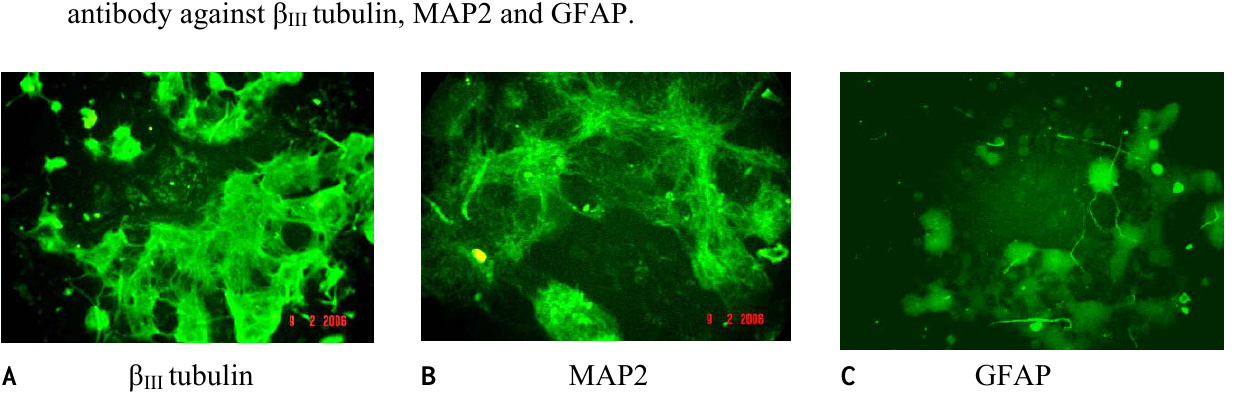
Figure 1. Photomicrographs showing control neurospheres stained using FITC- conjugated tubulin, MAP2 and antibody against β III